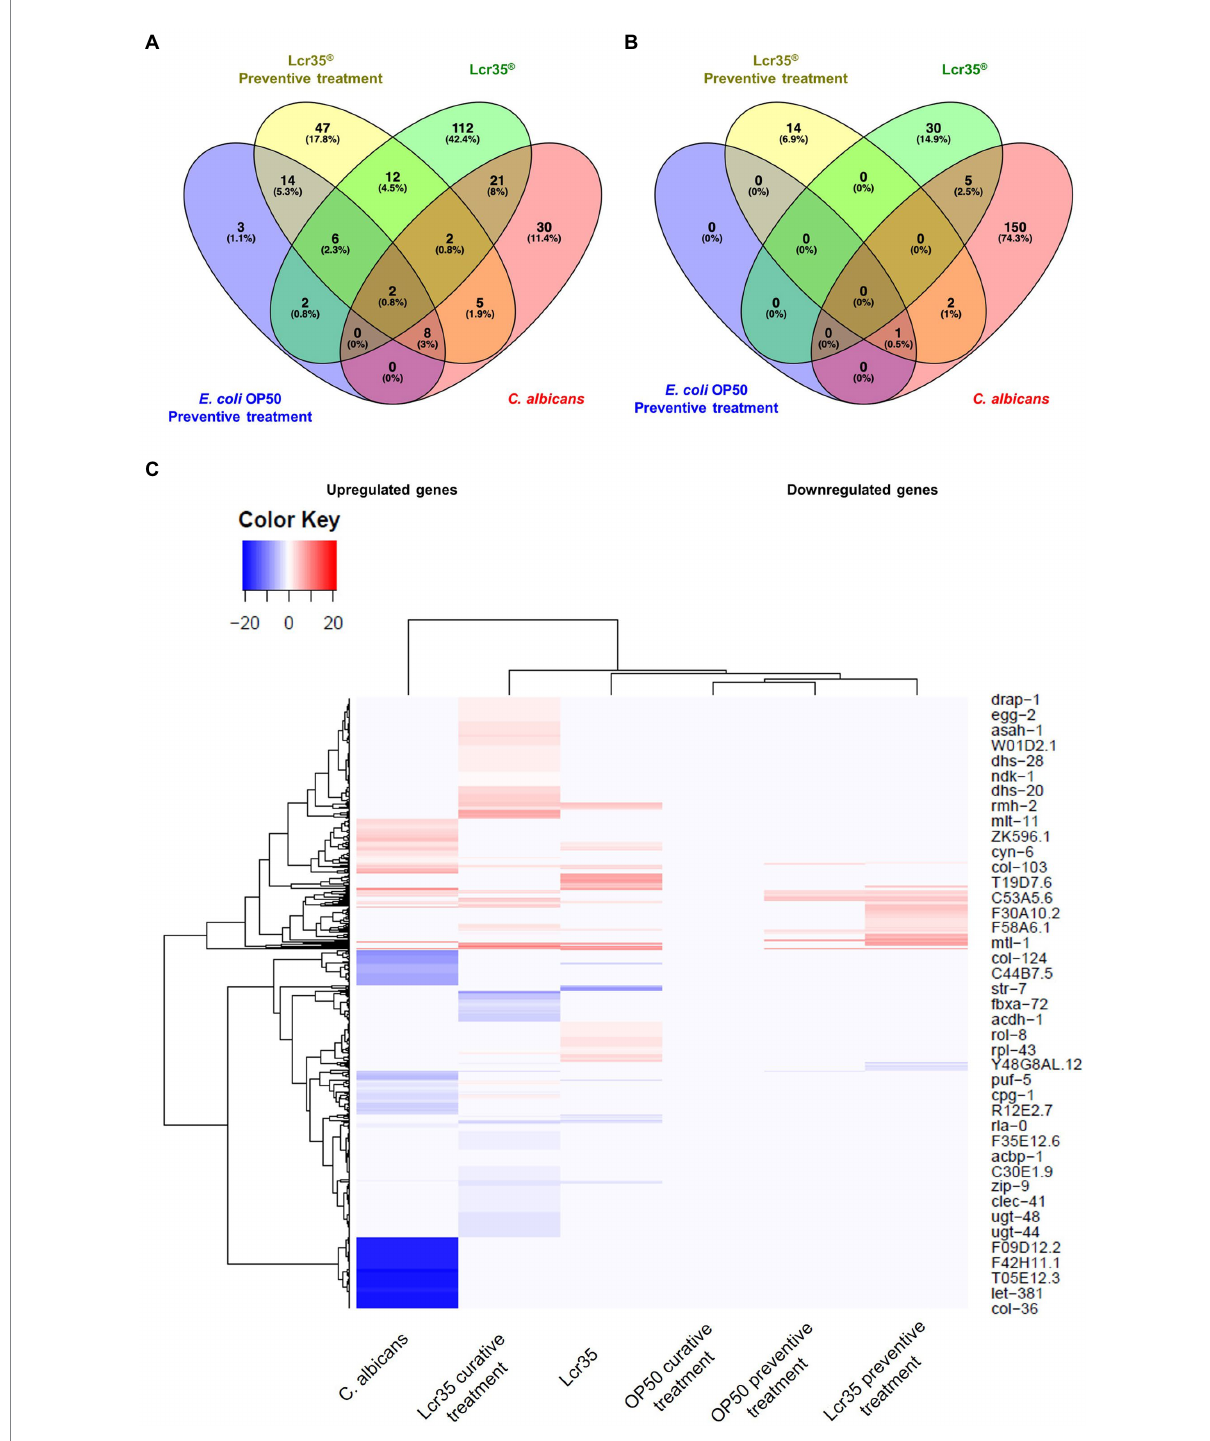
FIGURE 5 The transcriptional responses to E. coli OP50 as a preventive treatment and L. rhamnosus Lcr35 ® as a preventive treatment comprises specific and overlapping gene sets. Venn diagrams illustrate the overlap genes significantly upregulated (A) or downregulated (B) . Animals were exposed to the bacterial strains for 4 h and infected by the yeast for 2 h. (C) Clustering heatmap of differentially expressed genes during a preventive or a curative treatment. Red color indicating significantly highly expressed genes and blue color indicating significantly down-regulated genes. The exhaustive list of genes is given in Supplementary Tables S3,